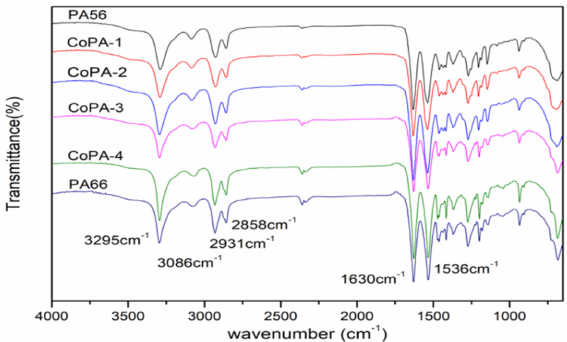
Figure 1. FTIR spectra of the PA56/66 copolyamides.